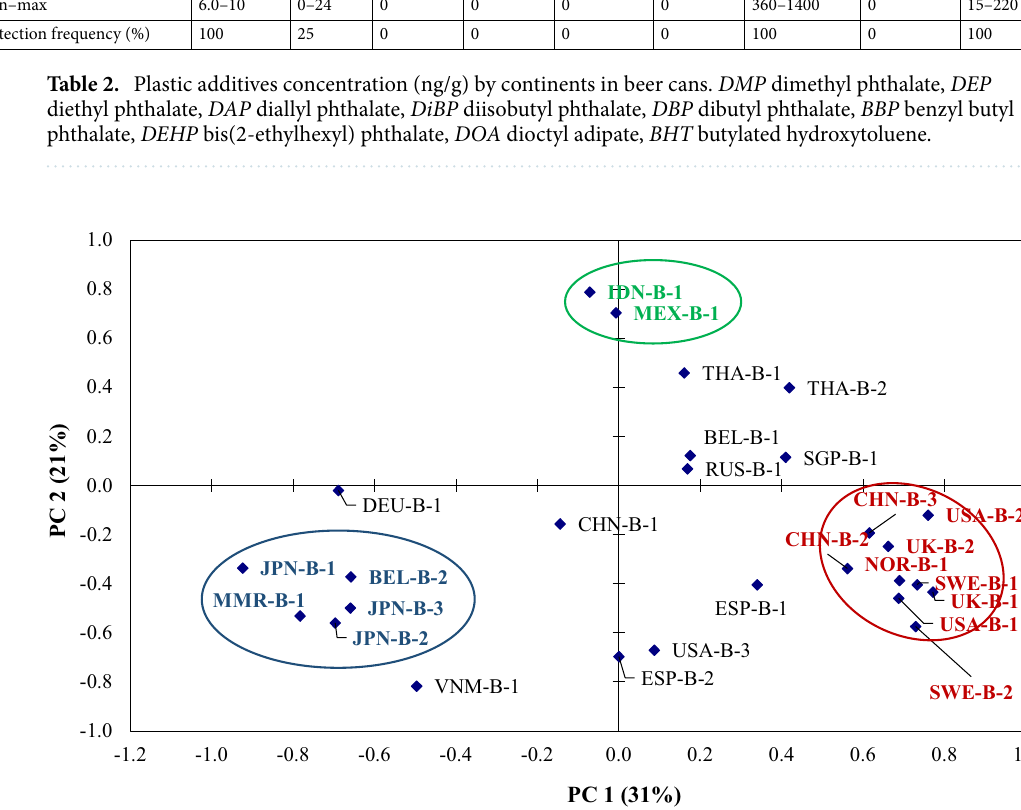
Figure 5. Principal component analysis (PCA) to the plastic additive compositions in beer cans (DMP, DEP, DiBP, DBP, DEHP, DOA, and BHT). The eigenvalues of PC1 and PC2 are described in Table